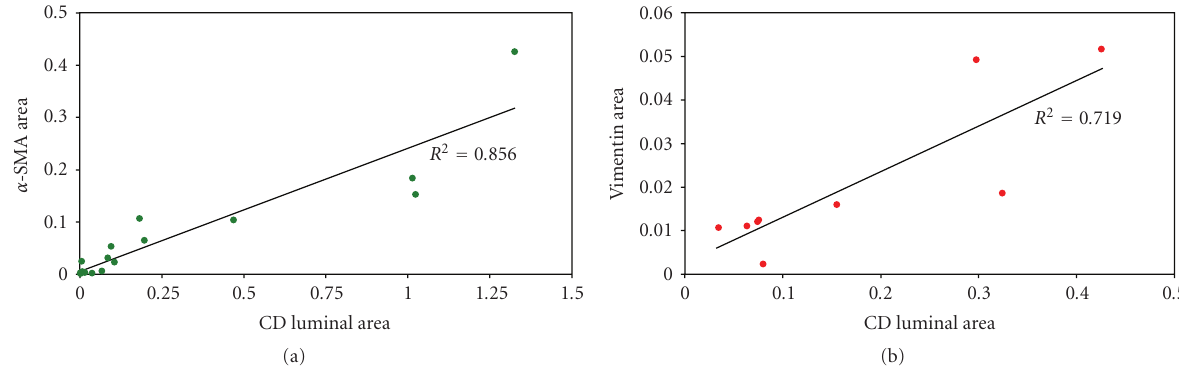
Figure 6: Correlation of the severity of CD dilatation with periductal collar formation and with CD epithelial vimentin expression . The relationship between CD dilatation ( x -axis), and the areas of periductal collars expressing α -SMA (a) and of CD epithelium expressing vimentin (b) ( y -axis) is shown. Measurements were performed in obstructed fetal (36 weeks gestation) and postnatal (16 months) kidneys ( n = 3). All areas are expressed in mm 2